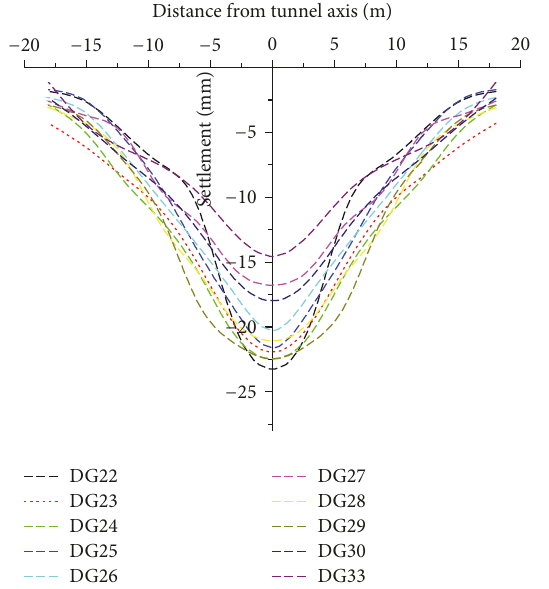
Figure 10: Surveying curves of some